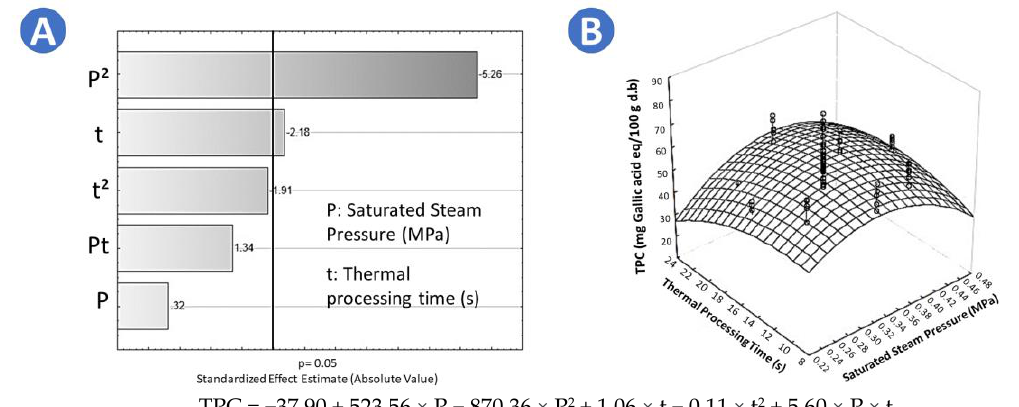
Figure 1. Effects of steam pressure (MPa) and thermal processing time (s) on the total phenol content (TPC) of swell-dried chokecherries. ( A ) Pareto chart and ( B ) surface response plot.